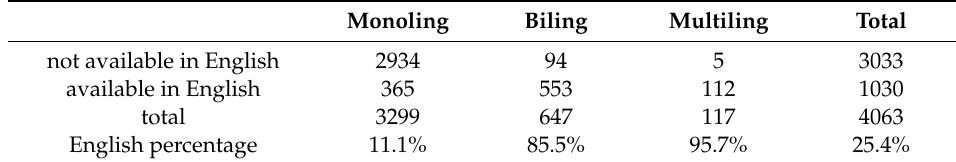
Table A4. English language availability (be).